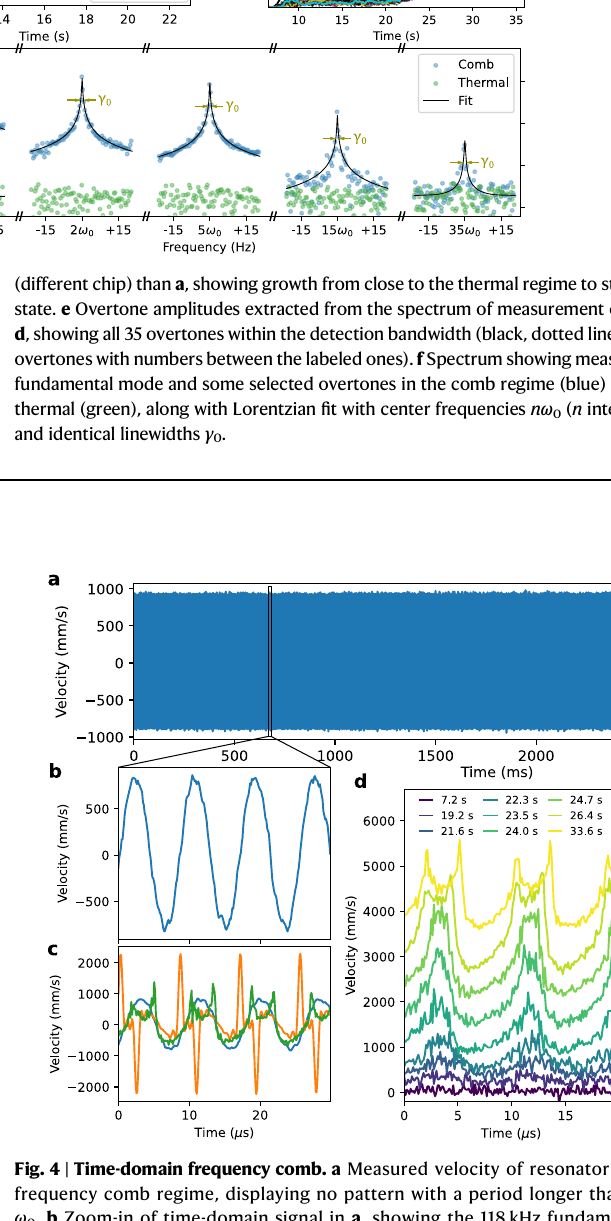
Fig. 4 | Time-domain frequency comb. a Measured velocity of resonator in frequency comb regime, displaying no pattern with a period longer than 1/ ω 0 . b Zoom-in of time-domain signal in a , showing the 118kHz fundamental mode dominates. c Three different measured time signals in steady state, with varying relative strengths of the overtones (blue: ω 0 dominates, orange: 2 ω 0 and 3 ω 0 dominate, green: 1 ω 0 to 6 ω 0 similar in strength). All traces can be reproduced only with phase-coherent addition of the different overtones. d Time-domain signal of comb during growth, the same measurement as Fig. 3e at the indicated times. This shows the smooth transition from the thermal regime (bottom) to the comb in a steady state (top), traces are offset vertically for